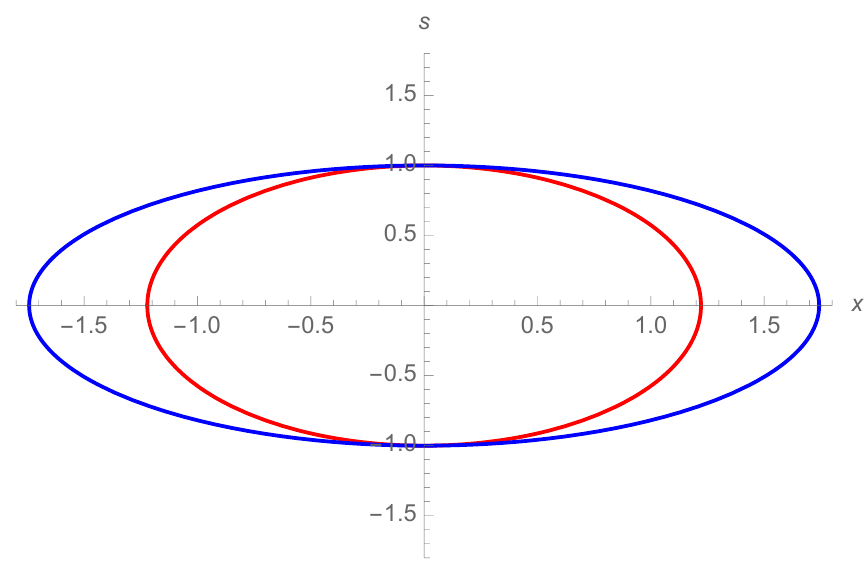
Figure 1 . Uncharged Membrane surface with rotation along one direction for (cid:7) = 0 : 47 for the + and (cid:0) branch of